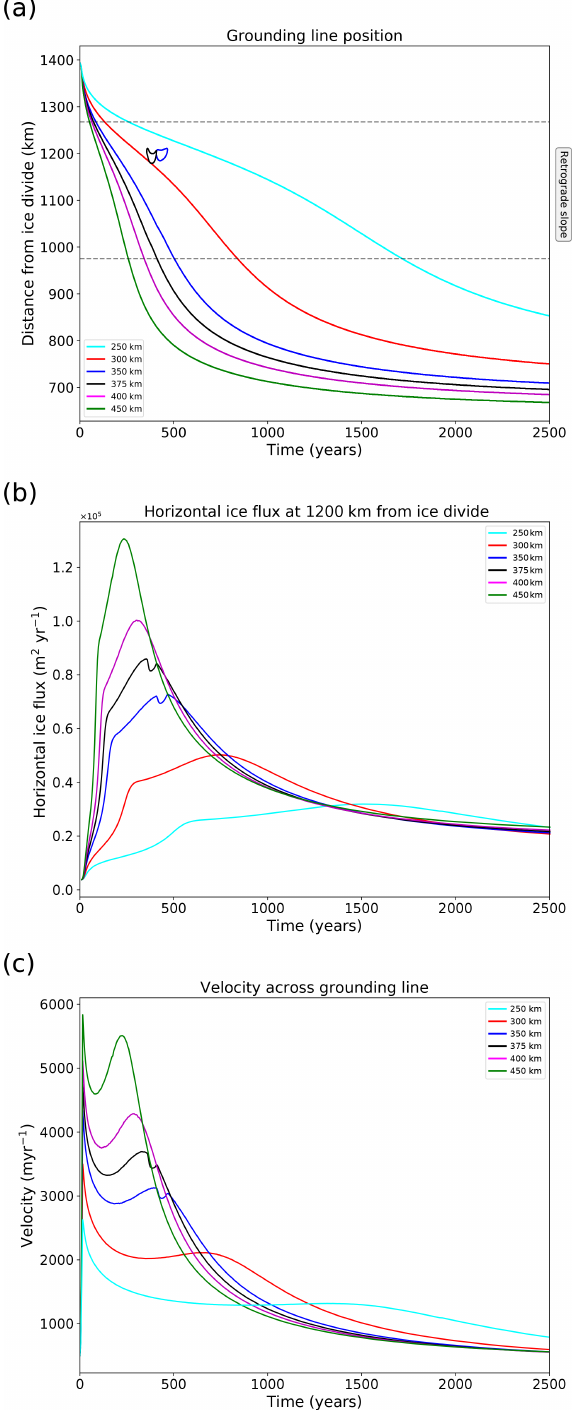
Figure 1. Retreat experiments using the cavitation sliding relation. (a) Evolution of grounding line position over time for a range of parameterised channel half-widths. Dashed lines indicate the extent of the retrograde bedrock. (b) Total flux of ice in the horizontal direction across a line 1200km from the ice divide. (c) Sliding speed across the grounding